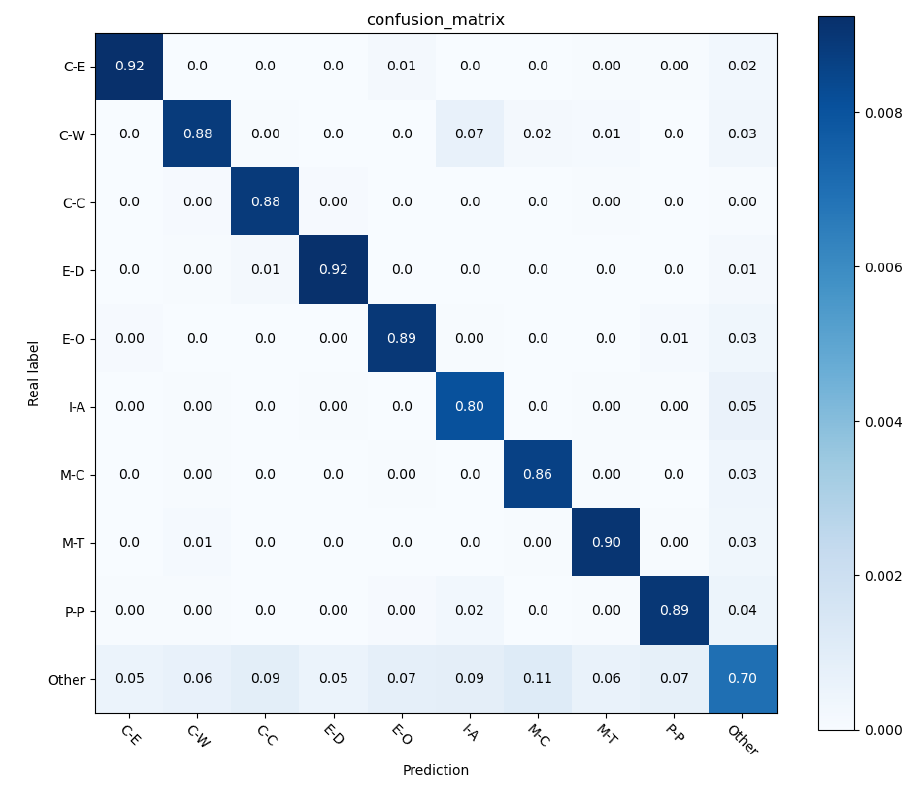
Figure 6. 10 Confusion matrix of classified (non-differentiated direction) results.